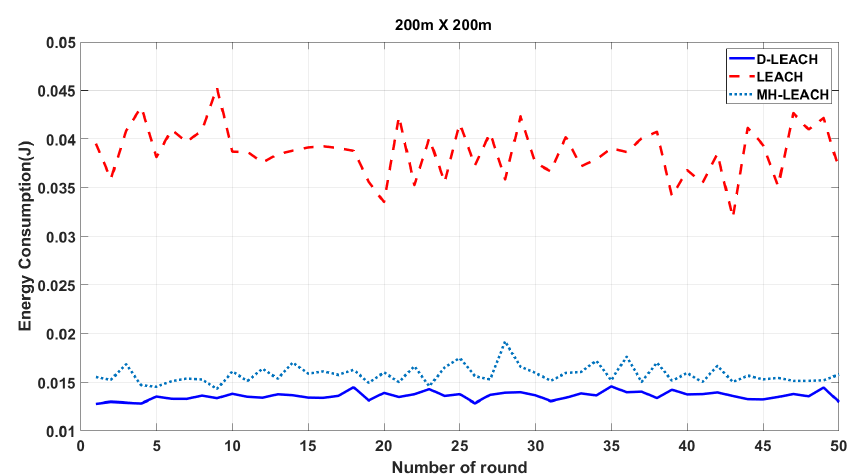
Figure 19. Energy consumption (200 × 200 m 2